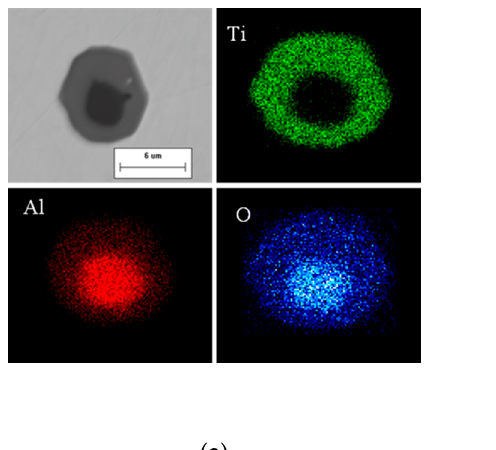
2 O 3 -TiO x and ( b ) TiO x -MnS. Reproduced